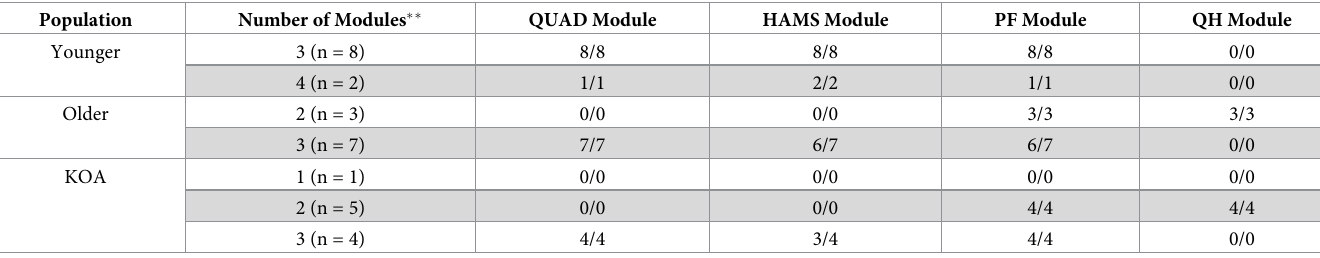
Table 3. Number of participants with correlated module within population � .